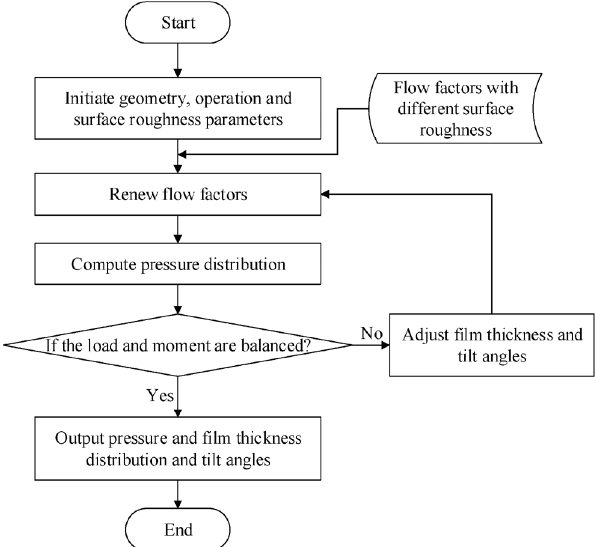
Fig. 3 Flow chart of the tilt pad thrust bearing simulation.